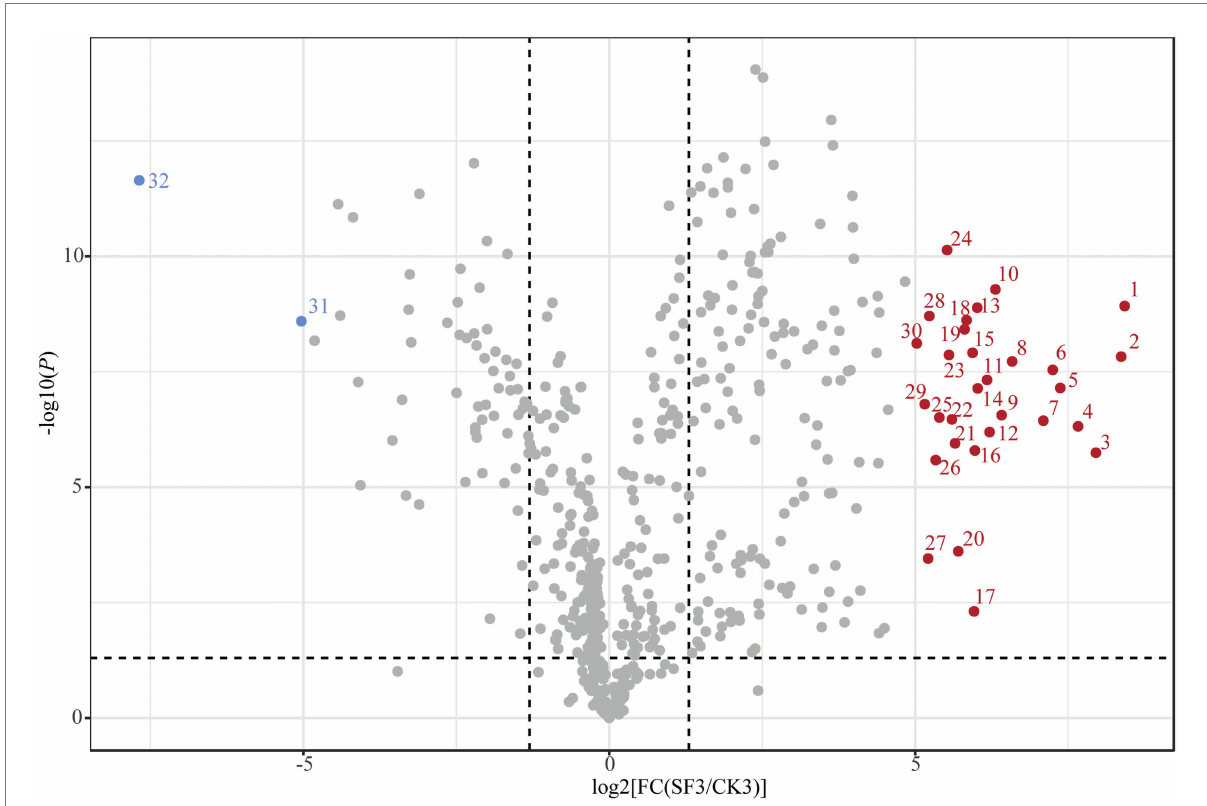
FIGURE 5 Volcano plot showing the contribution of nVFCs in SF3 and CK3 in OPLS-DA. The first data in the brackets is the number of metabolites, the second data are the percentage of each metabolites in the total nVFCs in CK3 and the third data is that in SF3. 1: Prolyl-Valine; 2:LysoPE(0,0/22,0); 3:Enkephaline, (D-Ala)2-Leu; 4: Agavoside A; 5: 6-{[(16S)-5,7-dihydroxy-8,8,12,16-tetramethyl-3-[1-(2-methyl-1,3-thiazol-4-yl)prop-1-en-2-yl]- 10-methylidene-9-oxo-17-oxa-4-azabicyclo[14.1.0]heptadec-4-en-11-yl]oxy}-3,4,5-trihydroxyoxane-2-carboxylic acid; 6: Gamma- Glutamylphenylalanine; 7: 6-{[(16S)-5,7-dihydroxy-8,8,10,16-tetramethyl-3-[1-(2-methyl-1,3-thiazol-4-yl)prop-1-en-2-yl]-12-methylidene-9- oxo-17-oxa-4-azabicyclo[14.1.0]heptadec-4-en-11-yl]oxy}-3,4,5-trihydroxyoxane-2-carboxylic acid; 8: Asp-Phe; 9: Physagulin D; 10: (+/ − )-Hexanoylcarnitine; 11: Isoleucyl-Leucine; 12: Adenosine 3 ′ -monophosphate; 13: PS(MonoMe(11,5)/MonoMe(11,3)); 14: Uridine diphosphate- N-acetylglucosamine; 15: Physapruin B; 16: 7a-Hydroxy-5b-cholanic acid; 17: Isoleucyl-Isoleucine; 18: Isoleucyl-Tyrosine; 19: Digalacturonate; 20: 2,10-Bisaboladiene-1,4-diol; 21: (+/ − )-Octanoylcarnitine; 22: Isoleucyl-Alanine; 23: 2-(2,4-dihydroxyphenyl)-5,7-dihydroxy-6-(3-methylbut-2-en- 1-yl)-3,4-dihydro-2H-1-benzopyran-4-one; 24: N-(2-Phenylethyl)-acetamide; 25: L-cis-Cyclo(aspartylphenylalanyl); 26: Leucyl-Alanine; 27: Sulfolithocholylglycine; 28: Curcumadiol; 29: Caryoptosidic acid; 30: Ascorbyl stearate; 31: Acetylcholine; 32: